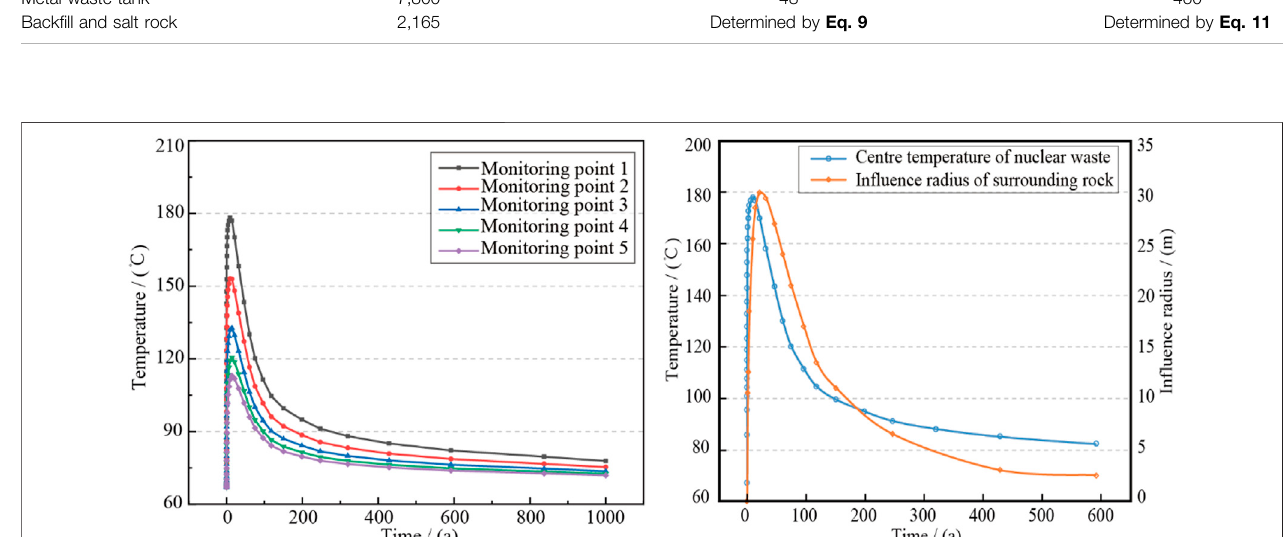
FIGURE 10 | The variation of disposal temperature with time. (A) Changes in temperature at different locations of the repository with time; (B) Change of radius of in fl uence of surrounding rock temperature with time.